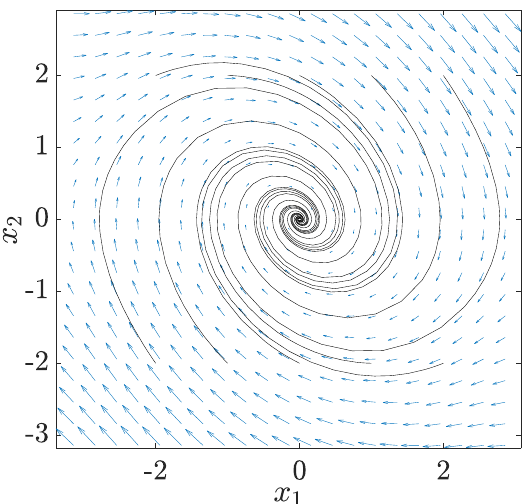
Figure 2. Pendulum dynamics stabilized by proposed